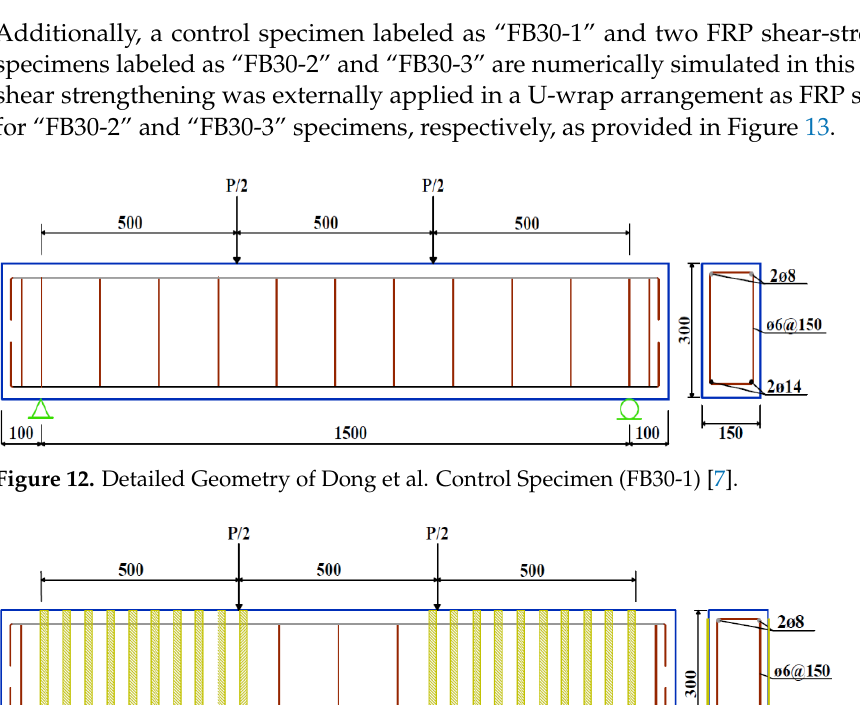
Figure 15. Detailed Geometry of Chaallal et al. CFRP-Strengthened Specimens (S1-0.33R, S3-EB) [55,56]. Figure 16. Typical Geometrical Characteristics of a T-Beam.